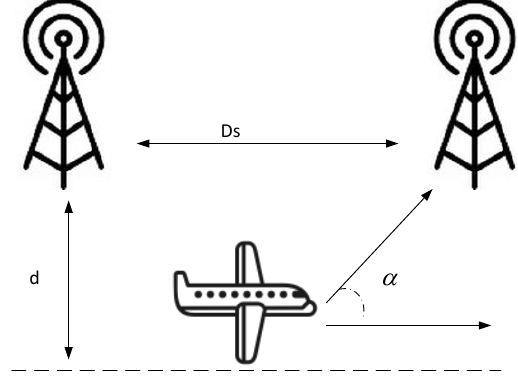
Figure 1. Scenario of a practical system.